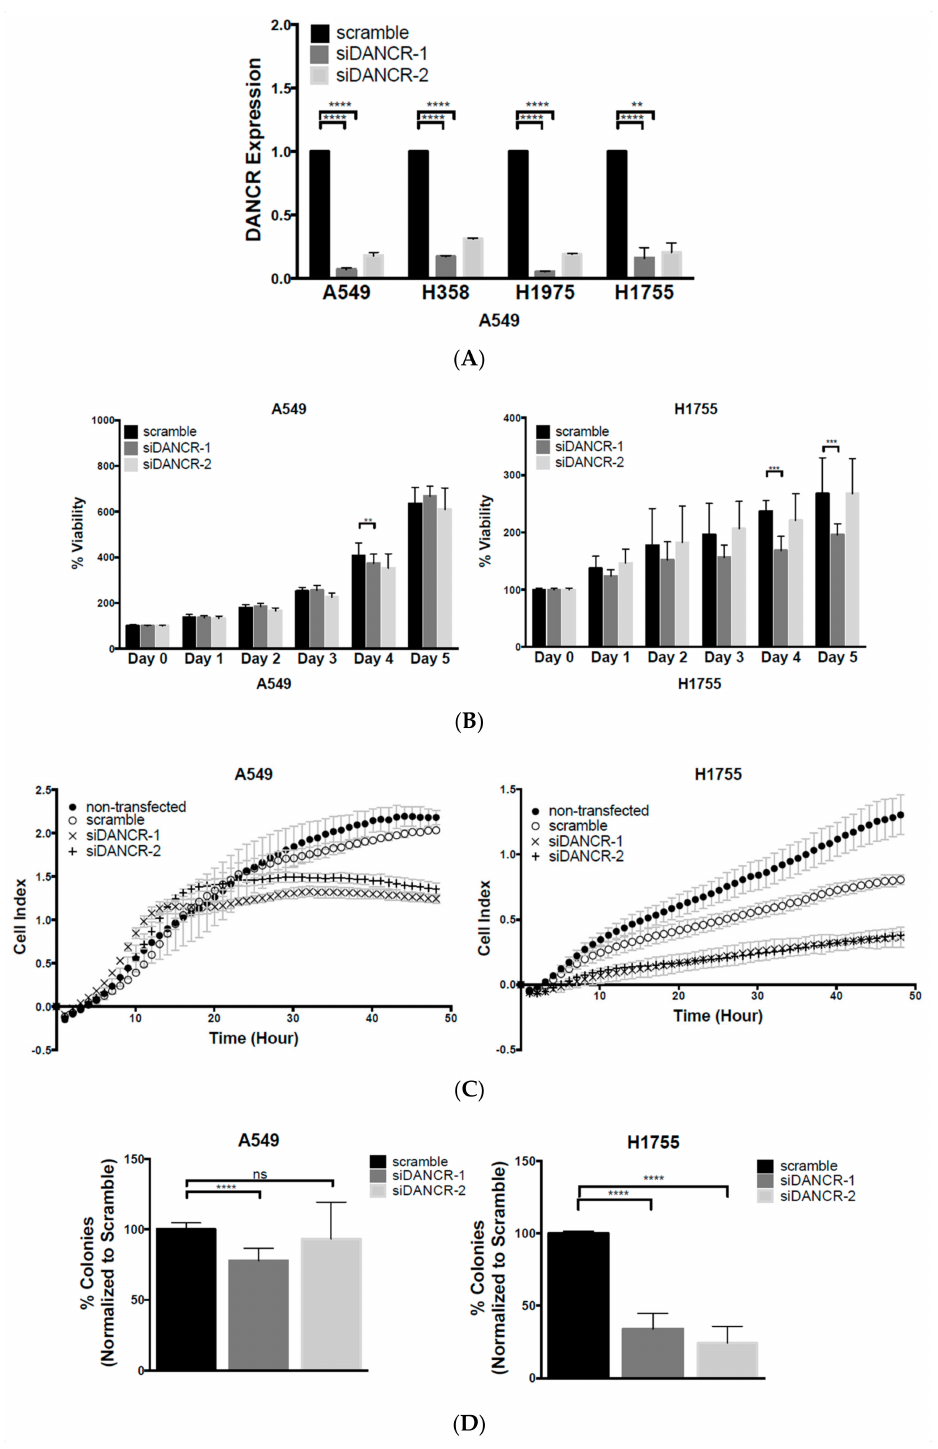
Figure 2. Knockdown (KD) of lncRNA-DANCR expression in NSCLC cells inhibits migration and clonogenic growth. ( A ) Fold change of DANCR expression in NSCLC cell lines A549, H358, H1975, and H1755 transiently transfected with two di ff erent DANCR siRNAs ( n = 3, t test, ** p < 0.01, **** p < 0.0001); ( B ) e ff ect of DANCR KD on cell growth of A549 and H1755 cells using Aqueous Cell Titer 96 reagent ( n = 3, 2-way ANOVA, ** p < 0.01, *** p < 0.001); ( C ) cell impedance assay using xCELLigence RTCA SP system on A549 and H1755 DANCR KD cells compared to scramble control ( n = 3); ( D ) colony-formation assay on A549 and H1755 two weeks after seeding ( n = 3, t test, **** p <